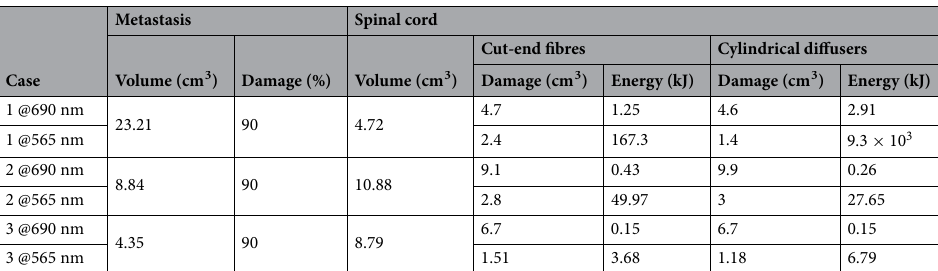
Table 4. PDT induced tumour and spinal cord damage as a function of wavelength and photon